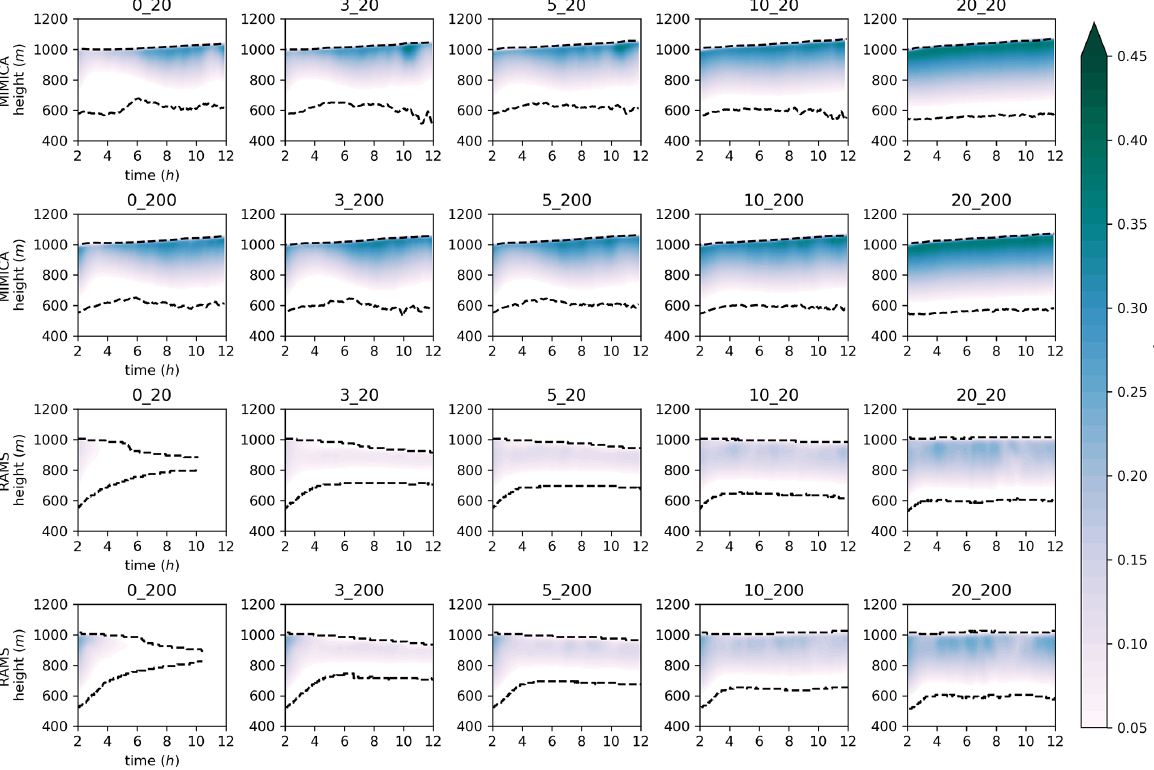
the cases simulated with the default κ value ( κ = 0 . 4; i.e.